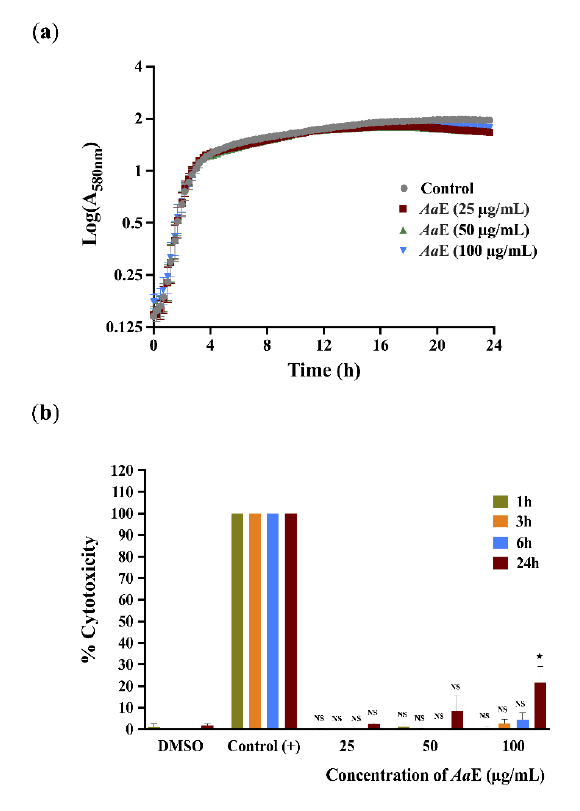
Figure 4. ( a ) Effect of Aa E on P. aeruginosa H103 growth. P. aeruginosa H103 was grown in the